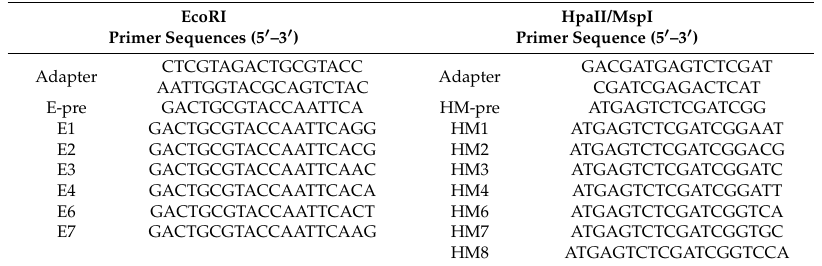
Figure 1. Salix viminalis in its growing and dormant seasons. ( a ) Salix viminalis in the growing season. ( b ) Salix viminalis in the dormant season. Table 1. Sequences of adapters and primers used in the methylation-sensitive amplified polymorphism (MSAP) analysis.